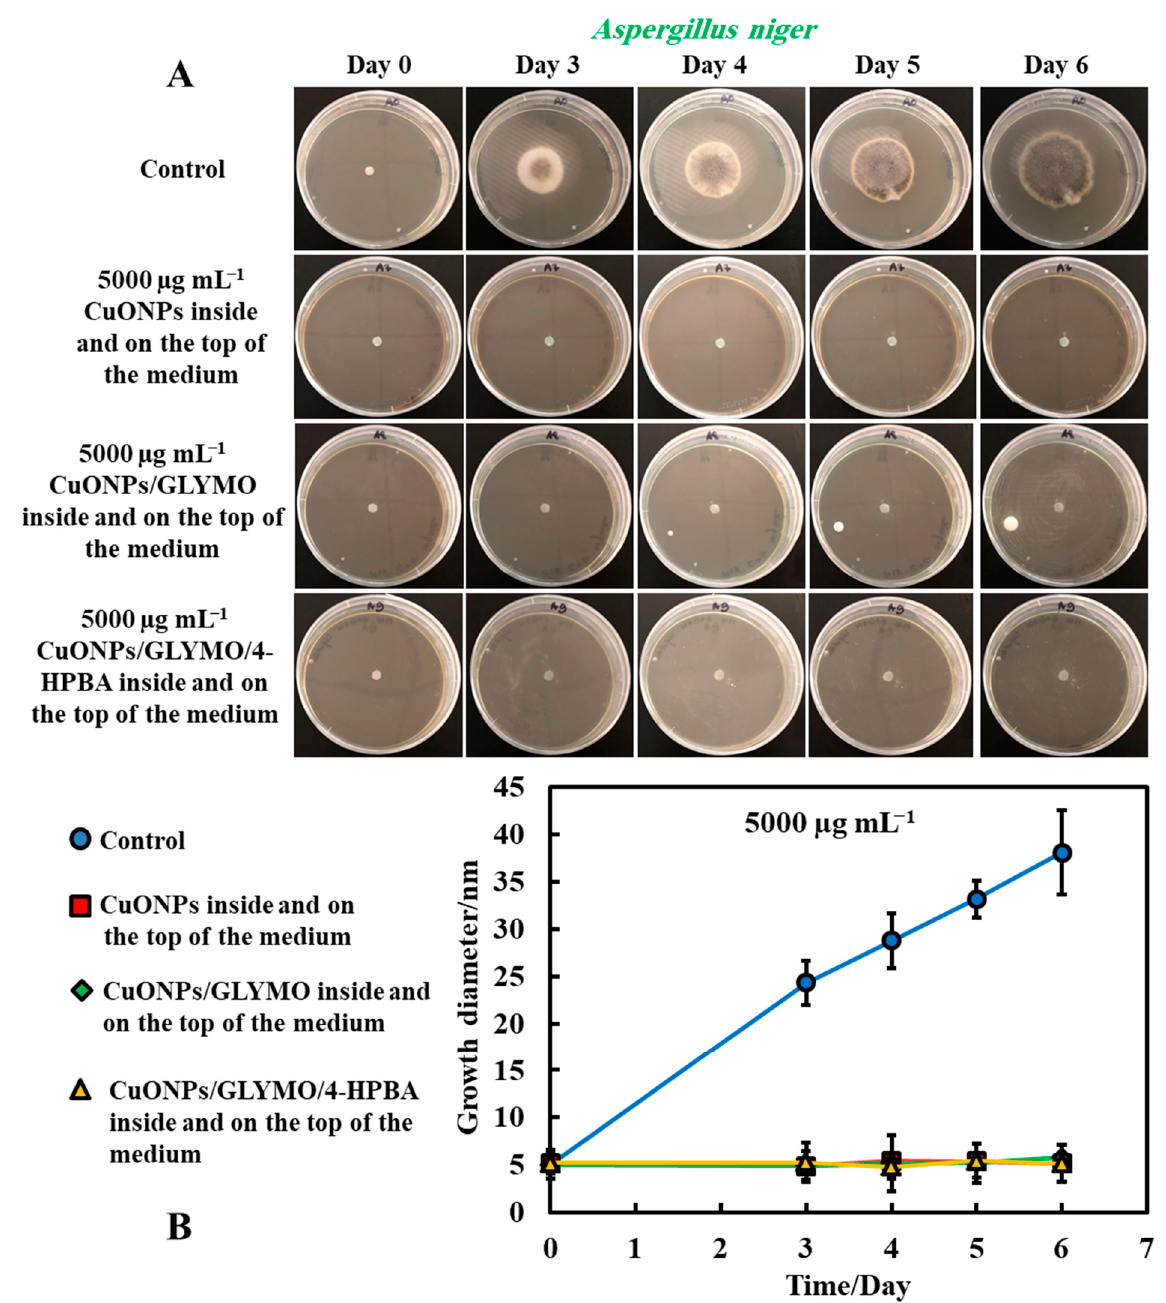
Figure 9. ( A ) Digital photographs of the PDA–gel plates containing A. niger in the center (impregnated paper disc) and with antimould agent at 5000 µ g mL − 1 inside and on the top of the medium (Method 4), monitored for six days, in an incubator, at 25 ◦ C. ( B ) Growth diameter of a circular spot of A. niger as a function of time for bare and surface-functionalized CuONPs. The solid lines are guides to the eye.